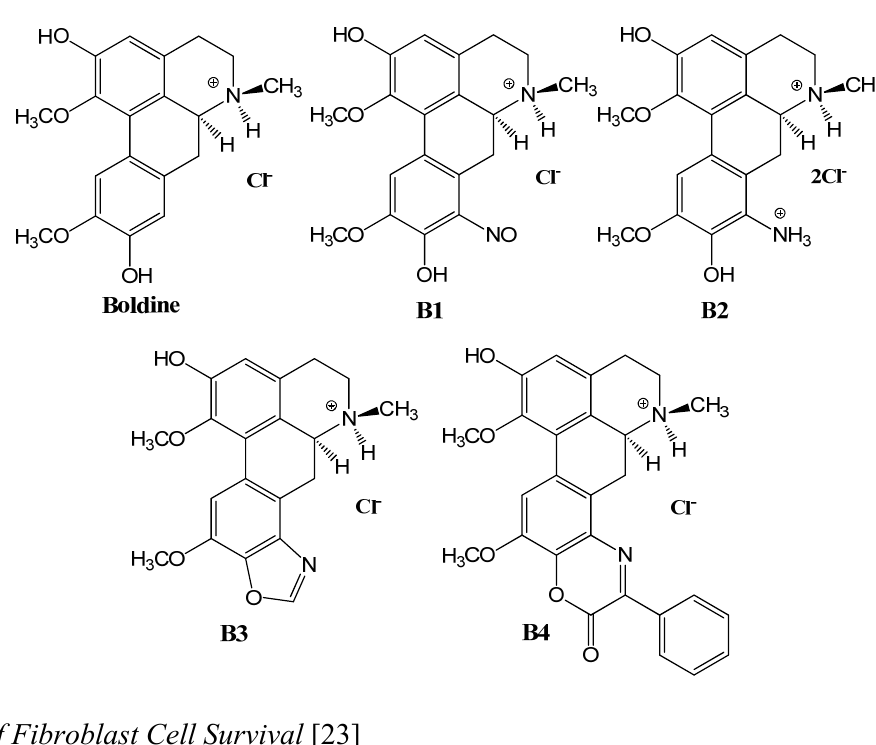
Figure 3. Chemical structures of boldine derivatives hydrochloride B1 – 4